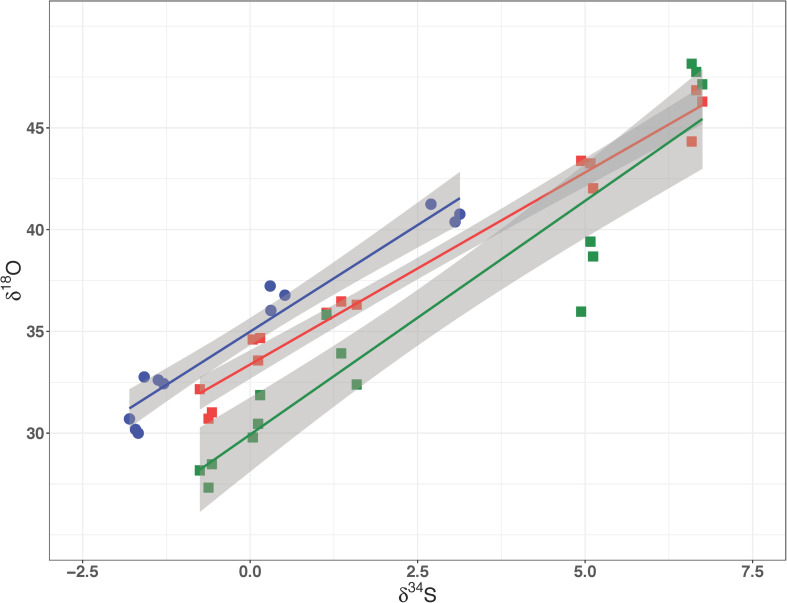
δ18O of residual sulfate plotted against its δ34S from the Rex batch culture mutant experiment. In all three strains these relationships are linear, suggestive of a dominant kinetic isotope effect. The data for WT, IR1and2, Δrex are in dark blue, red, and green, respectively.